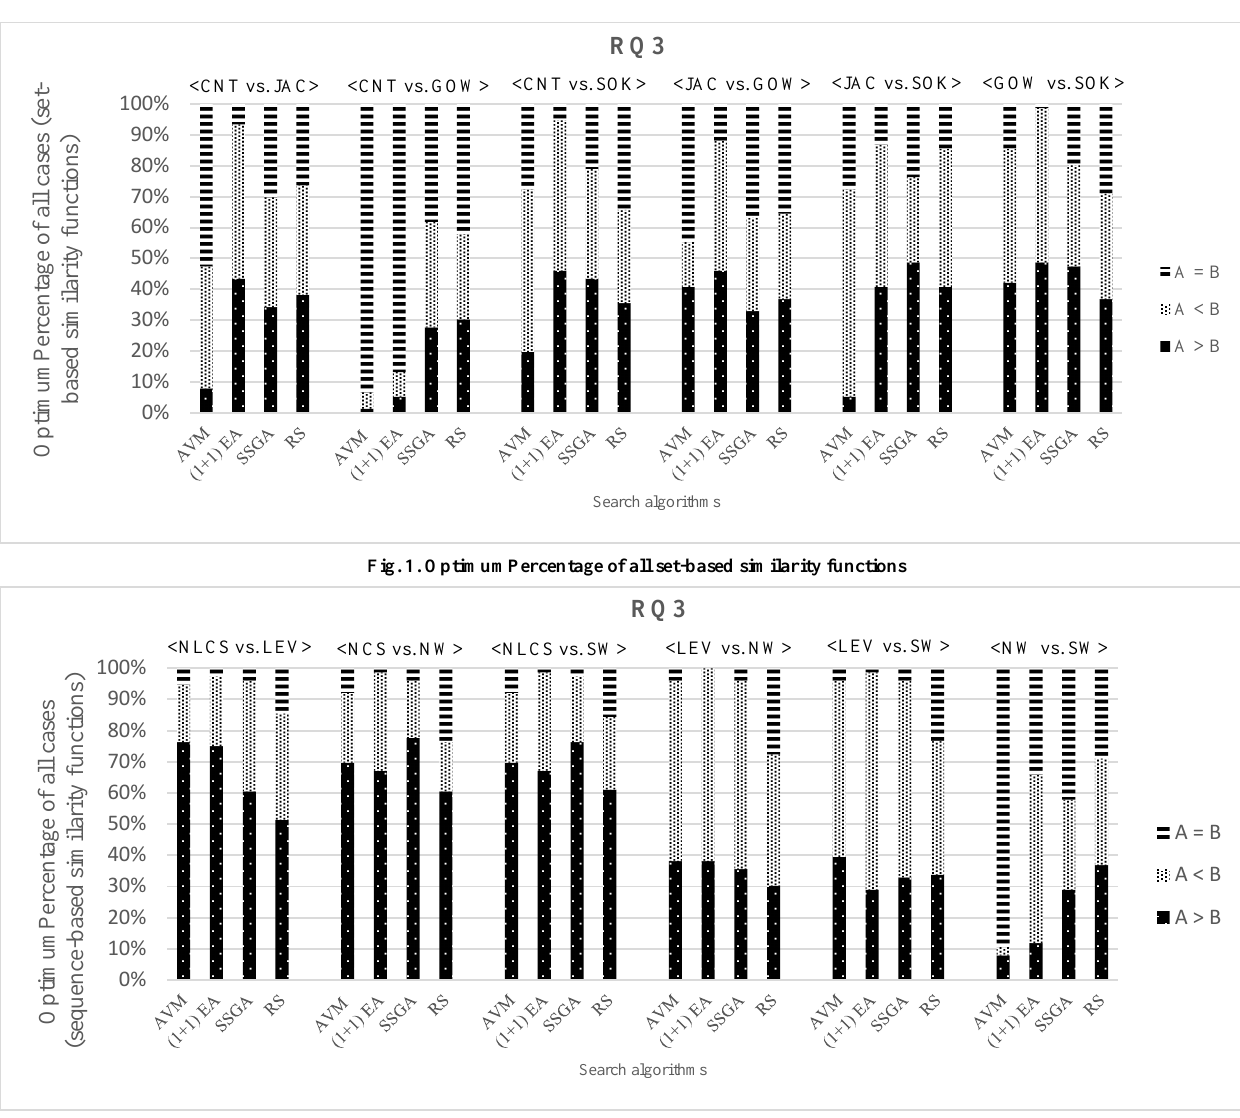
Fig. 2. OptimumPercentage of all sequence-based similarity